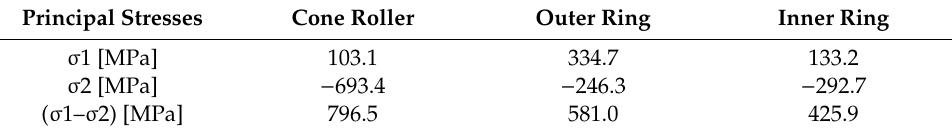
Figure 5. Distribution of the ( a ) first and ( b ) second principal stress-tapered rollers. Table 4. Principal stresses in tapered roller bearing-finite element